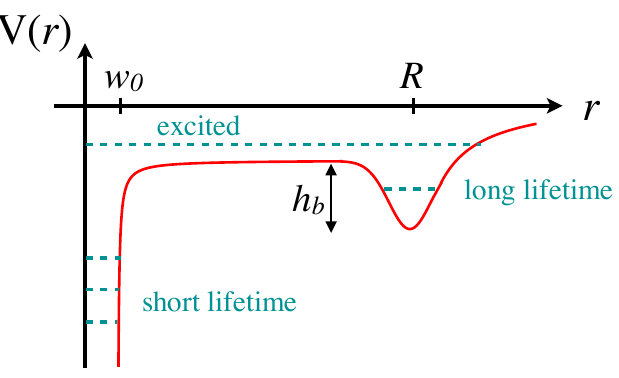
Figure 3 . An illustration of a two minima potential as described in section